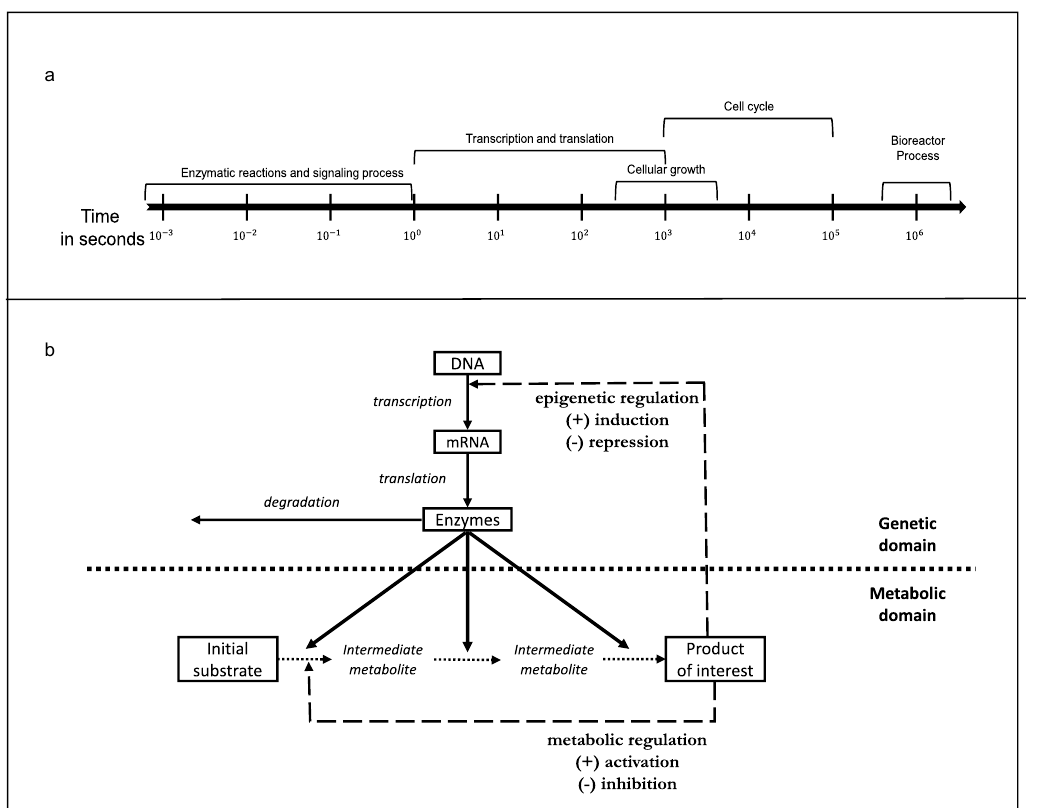
Figure 6. Bioprocesses time frames and possible regulation scheme. ( a ) Time scale of cellular operations. ( b ) Interacting regulatory mechanism in genetic and metabolic level (reproduced with permission from p. 16